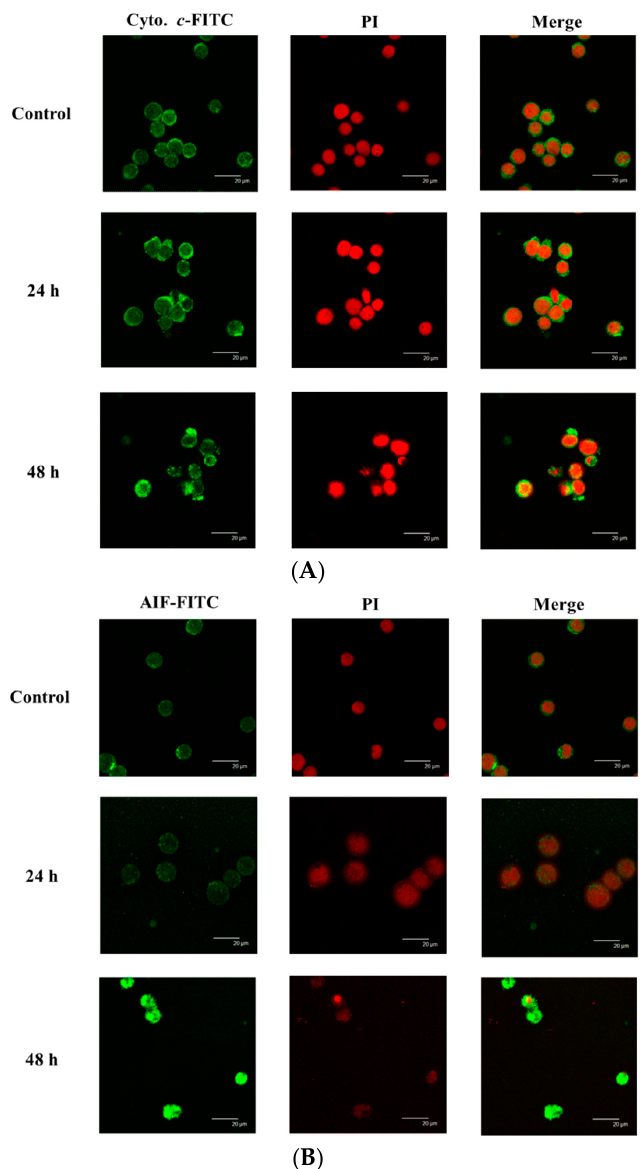
Figure 5. 18 α -GA affects the translocation of apoptotic associated proteins in HL-60 cells. Cells were treated with 100 μ M of 18 α -GA for 48 h and stained by anti- cytochrome c ( A ); and AIF ( B ) and then stained with secondary antibody and examined and photographed with a Leica TCS SP2 confocal laser microscopy system as described in the Materials and Methods section.